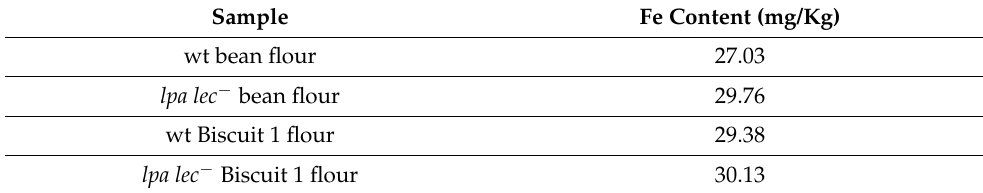
Table 6. Iron content in wild type (wt) and lpa lec − bean flours and Biscuit 1 flours.